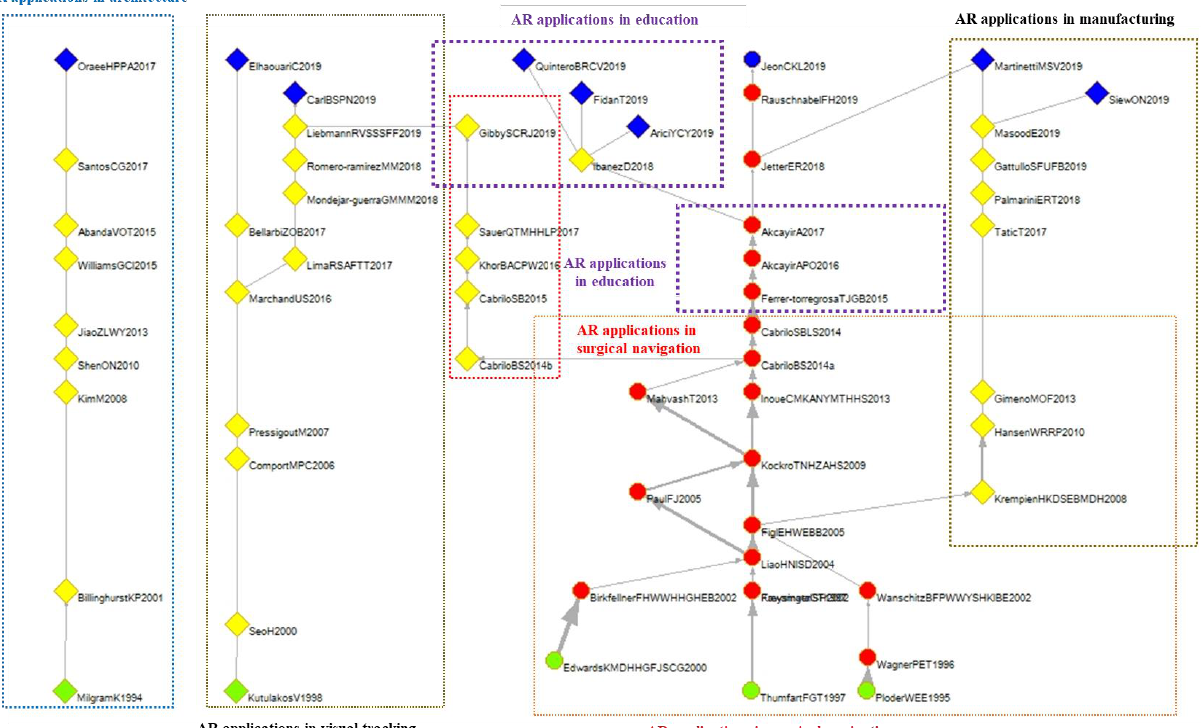
Figure 11. Main path relationship of AR-related papers and subfields.